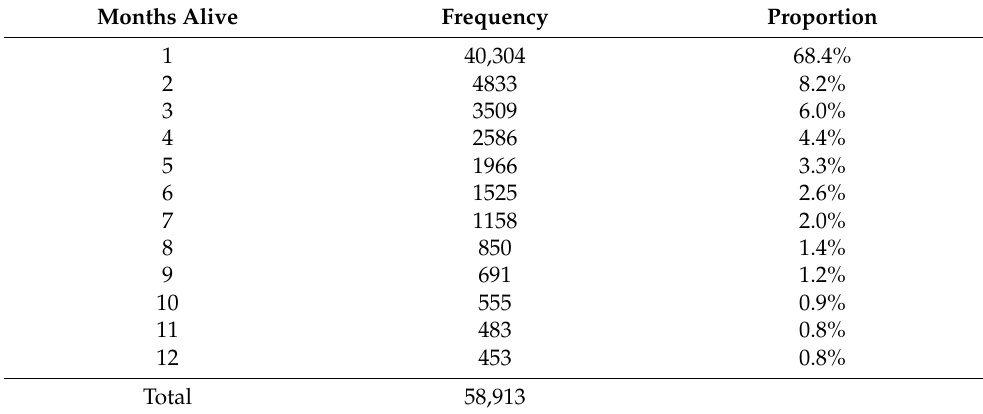
Table A2. Frequency table of number of months alive conditional on dying in the first year of life over the study